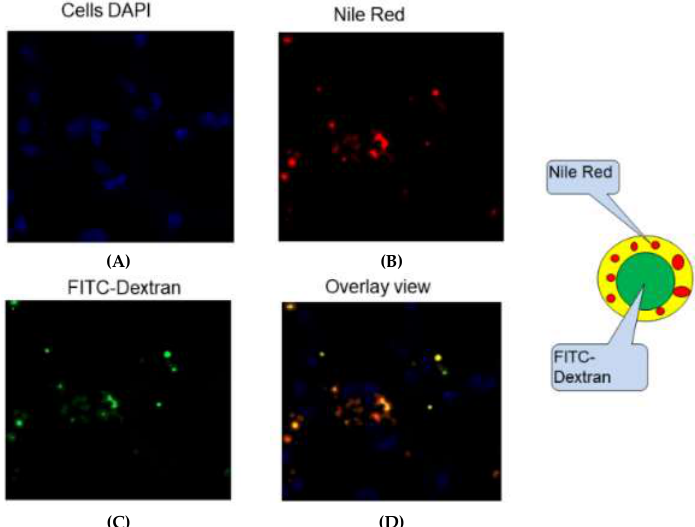
Figure 11. The cellular uptake of nanoparticles loaded with both FITC-Dextran (green, GRFT mimic) and Nile Red (red, DPV mimic) was investigated in RAW264.7 cells. Representative fluorescent microscopy images of RAW264.7 cells post nanoparticle exposure at 40 × magnification. ( A ) Fluorescence images show RAW264.7 cells nuclei stained with DAPI (blue) for positioning purpose, ( B ) images of Nile red (red) and ( C ) FITC-dextran (green) of same field were taken through di ff erent channels to illustrate the position of FITC-dextran (green) / Nile red (red) encapsulated nanoparticles in cells. ( D ) Overlay image showing coincident green and red signals as yellow color indicating uptake of intact nanoparticles.